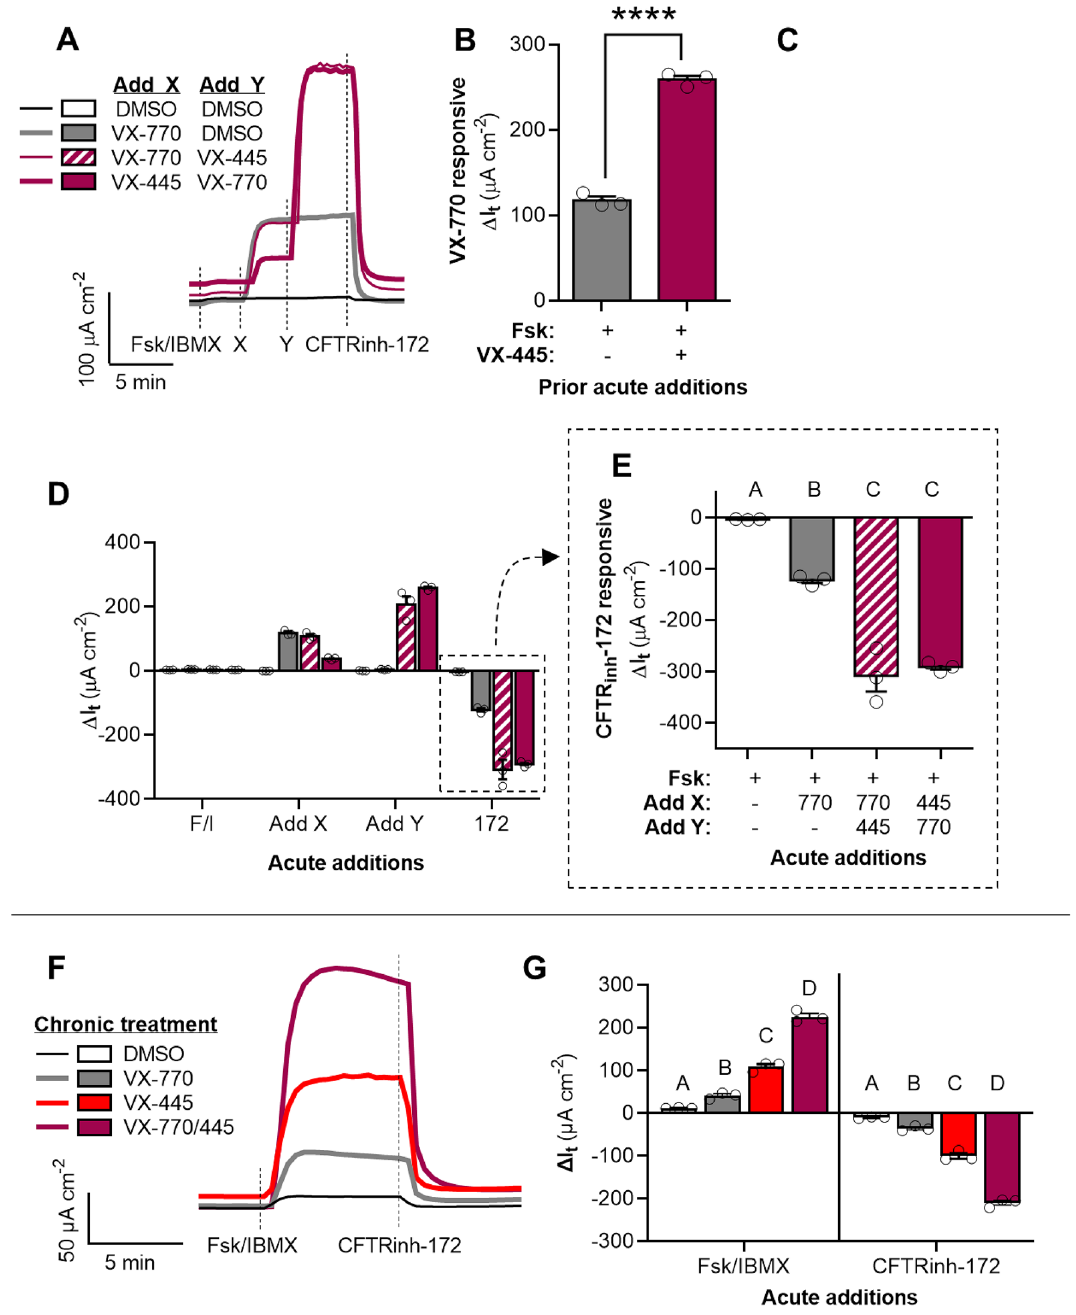
Figure 3. Synergism of ivacaftor (VX-770) and elexacaftor (VX-445) in potentiating G551D-CFTR in FRT cells. ( A ) Representative I t recordings of FRT cells expressing human G551D-CFTR showing acute actions of VX-770 and VX-445. ( B–C ) Changes in I t after acute addition of VX-770 in the absence and presence of VX-445 ( B ) and in response to the acute addition of VX-445 in the absence and presence of VX-770 ( C ). ( D–E ) Changes in I t after the additions of test compounds for the experiment presented in ( A) . G551D-CFTR mediated I t is greatest after acute potentiation by both VX-770 and VX-445. ( F ) Representative I t recordings of FRT cells expressing human G551D-CFTR treated for 24 h with DMSO, VX-770, and/or VX-445. ( G ) Changes in I t after the additions of test compounds for the experiment presented in ( F) . G551D-CFTR mediated I t is greatest after chronic treatment by both VX-770 and VX-445. See SI for additional experimental details and for supporting data. All data are presented as mean ± standard error. Bars with different letters (A, B, C…) are significantly different from each other (ANOVA; P < 0.05). Asterisks indicate specific P values: **** P <